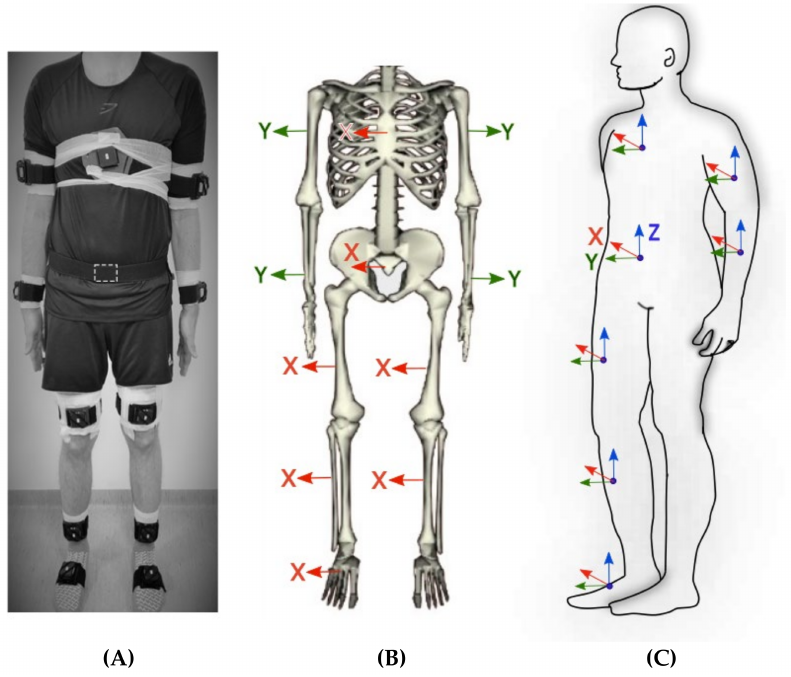
Figure 1. The ( left figure A ) illustrates the sensor placements on the thorax, upper and lower arms, legs, and feet. The person is standing in the neutral position. The pelvic sensor is placed on the back of the pelvis, and its position is marked with a dashed line. The orientation of the raw local sensor coordinate systems are shown in the segment model in the ( mid figure B ). The local segment coordinate system according to the segment model are illustrated in the ( right figure C ). For all segments, X pointed in the mediolateral direction (representing flexion-extension), Y pointed in the anterior direction (representing abduction-adduction), and Z in the inferior direction (representing inward/outward